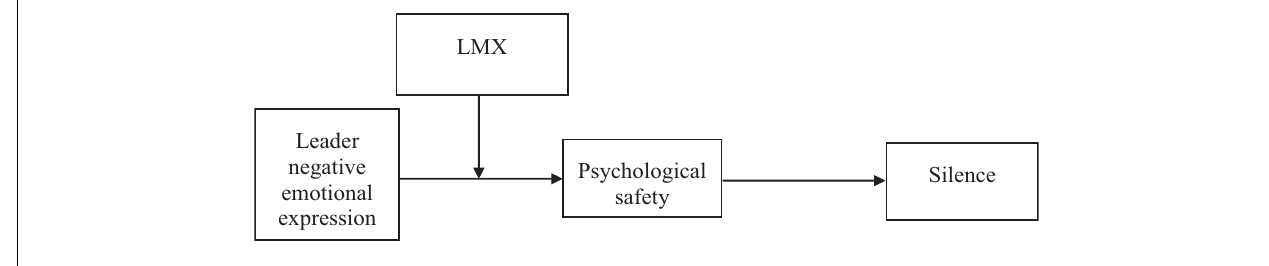
FIGURE 1 | Theoretical